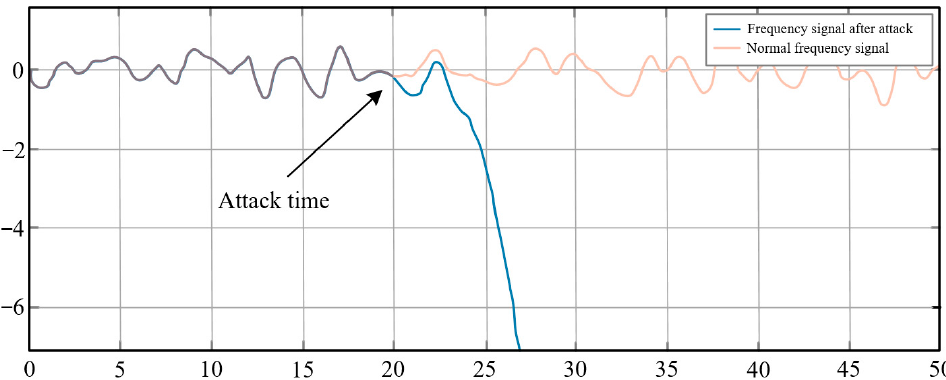
Figure 3. Change of system frequency deviation signal after being attacked by high-intensity nega- tive compensation ACE signal in the 20ths. compensation ACE signal in the 20th